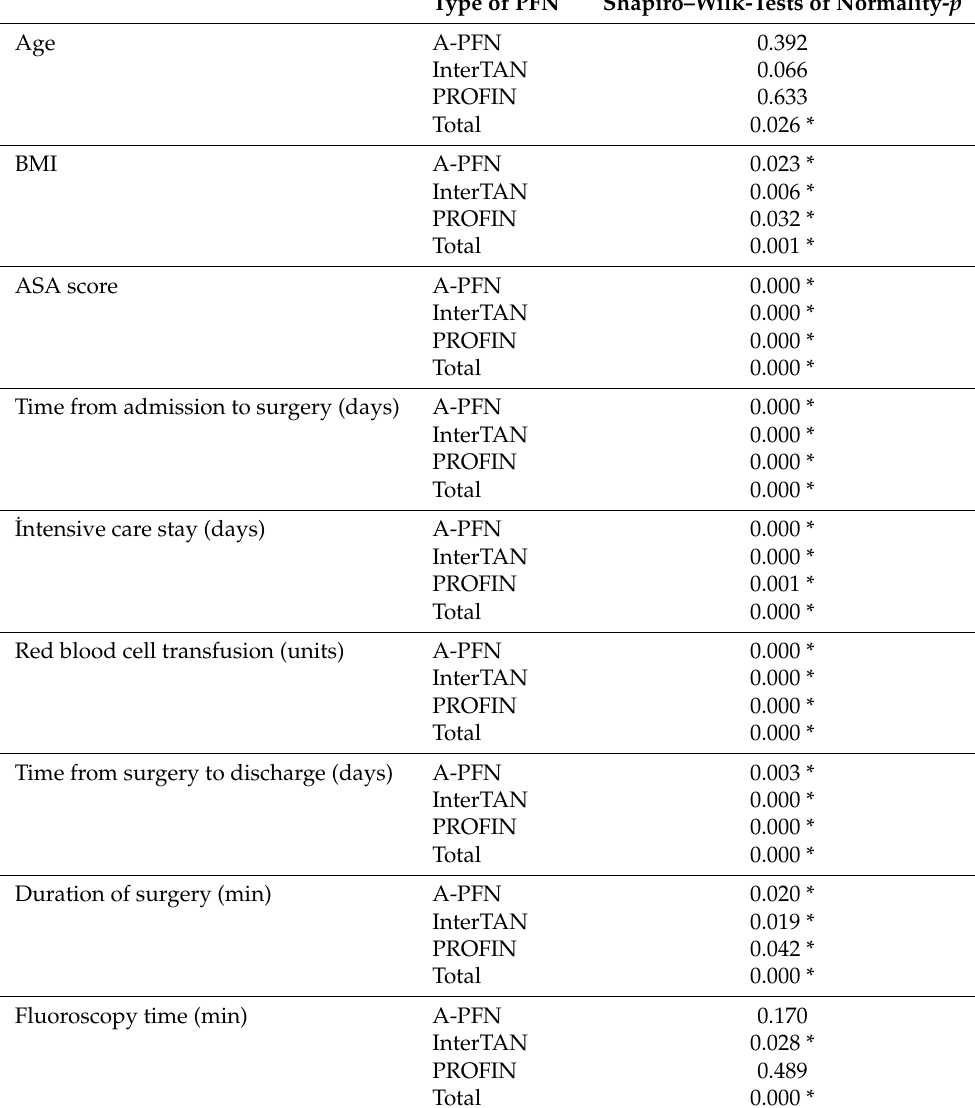
Table 1. Normality test results according to type of nail groups and in total. Type of PFN Shapiro–Wilk-Tests of Normality-